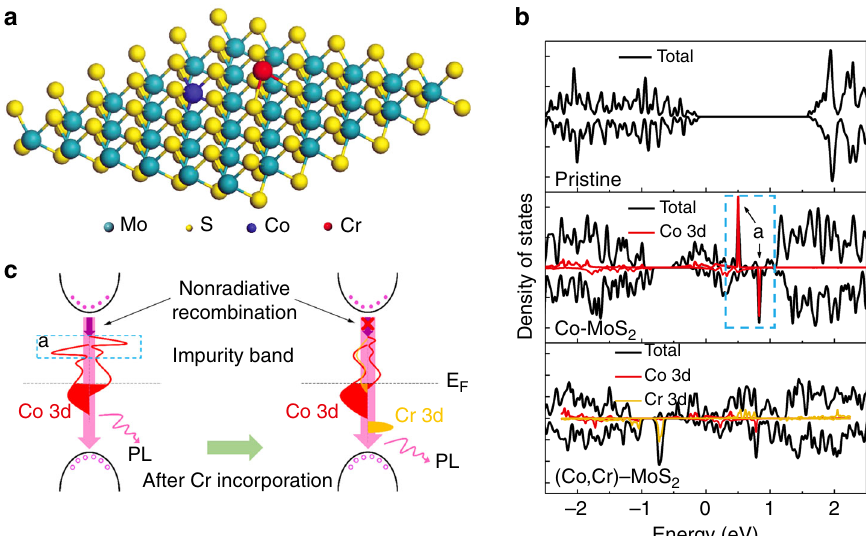
Fig. 5 The origin of the coexisting robust magnetism and PL. a Structure model for the DFT calculations on the (Co, Cr)-MoS 2 monolayer. b Calculated density of states (DOS) of monolayer MoS 2 : pristine MoS 2 , Co – MoS 2 , and (Co, Cr)-MoS 2 monolayers. c Schematic band structure of monolayer (Co, Cr)- MoS 2 with impurity